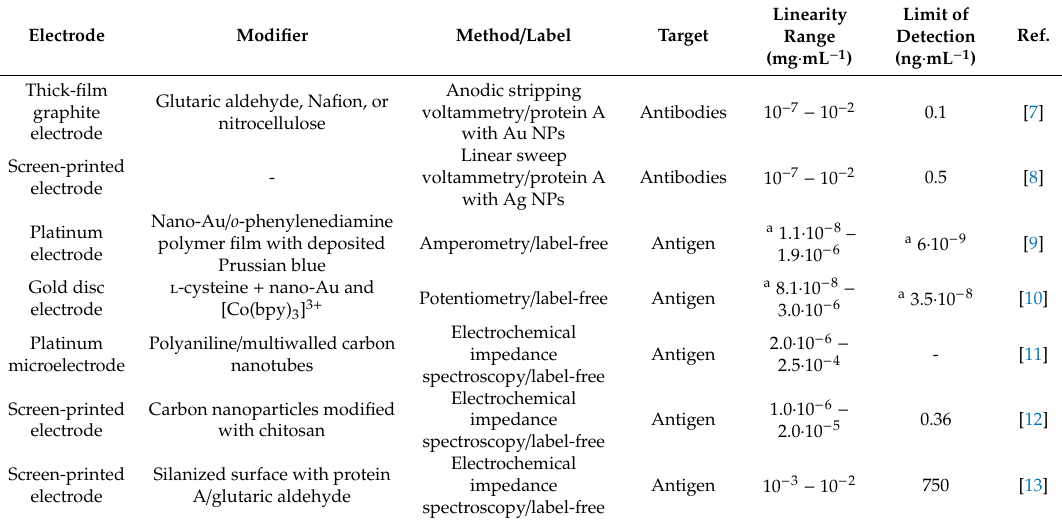
Table 1. Survey of electrochemical methods for determination of tick-borne encephalitis (TBE).